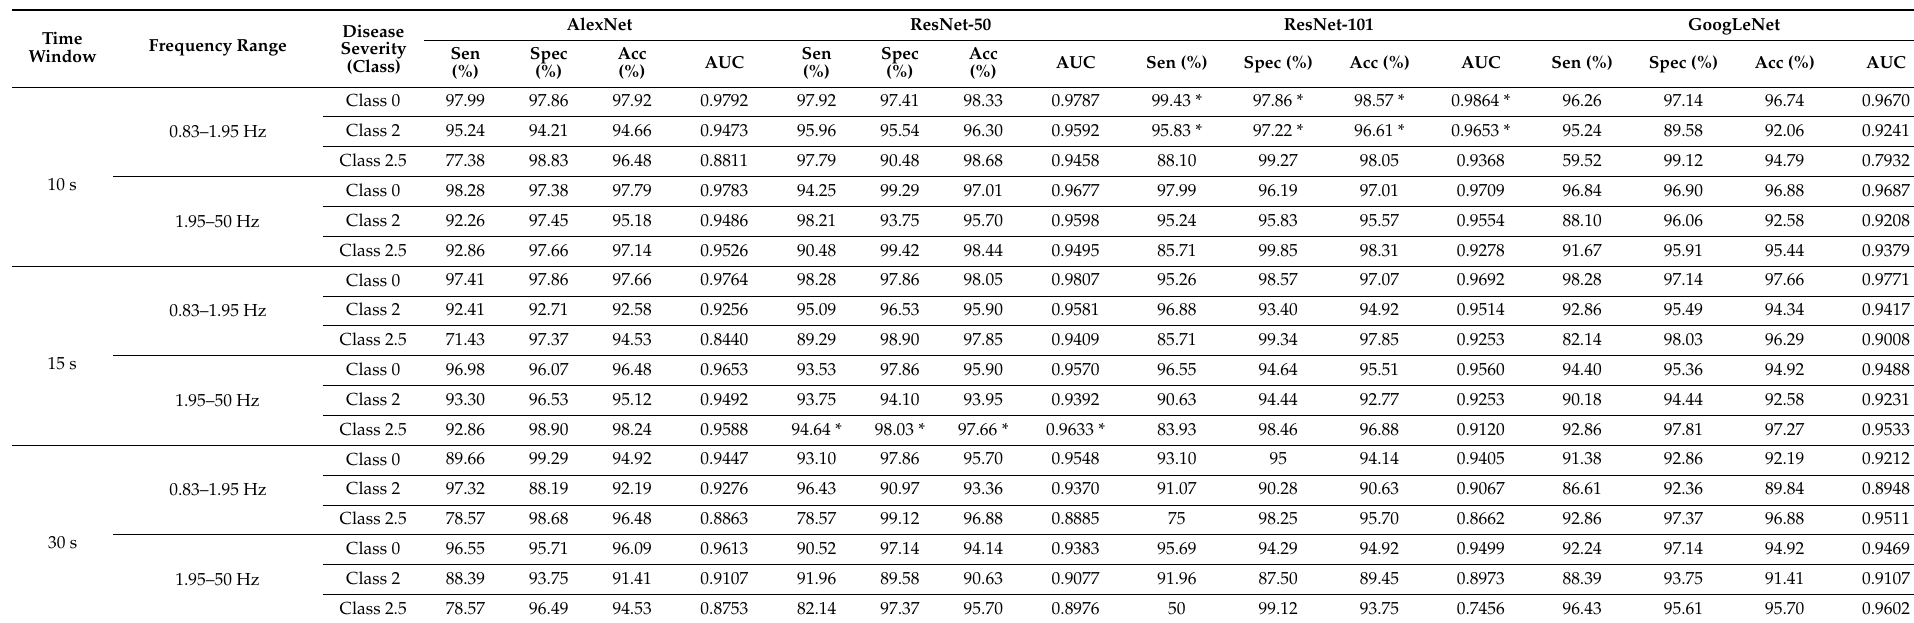
Table 10. Multi-class classification of RF from Si dataset for CO (Class 0), PD Stage 2 (Class 2), PD Stage 2.5 (Class 2.5), and PD Stage 3 (Class 3) using several CNN classifiers (AlexNet, ResNet-50, ResNet-101, and GoogLeNet) with 10-fold